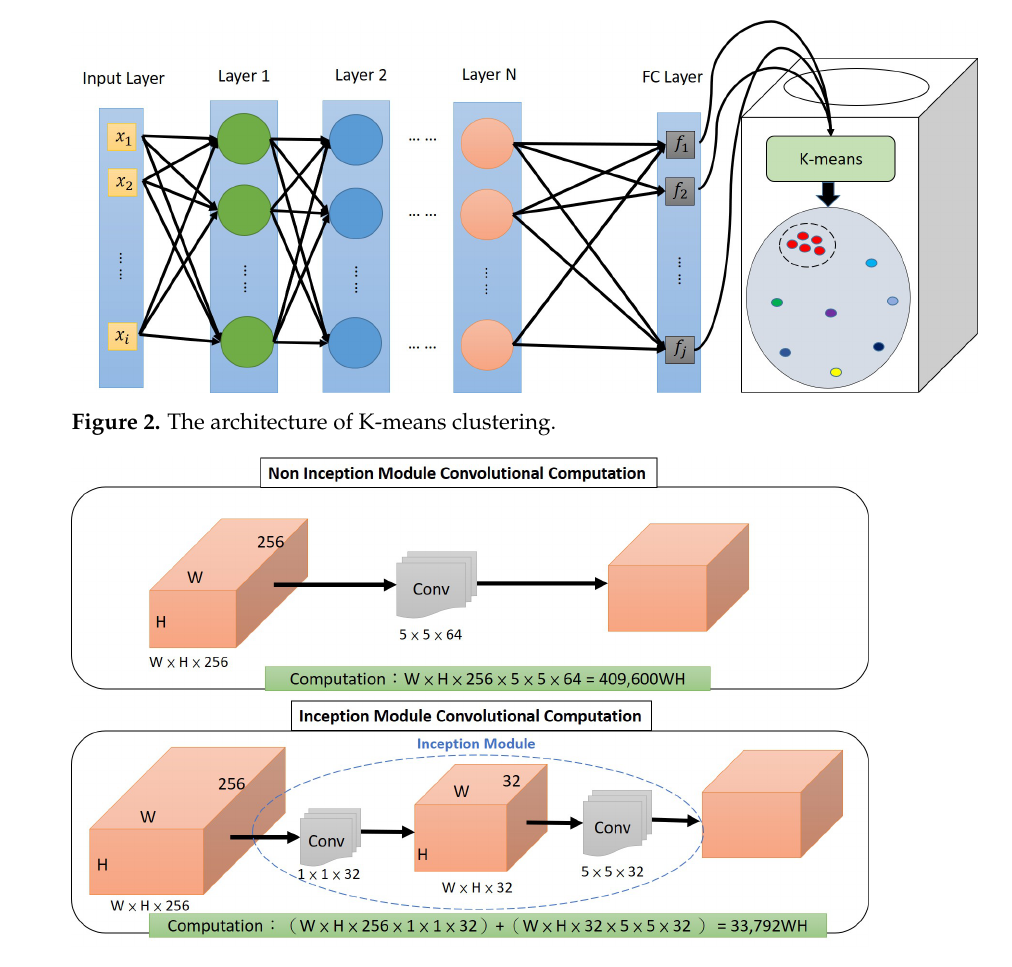
Figure 3. The reduction in computation